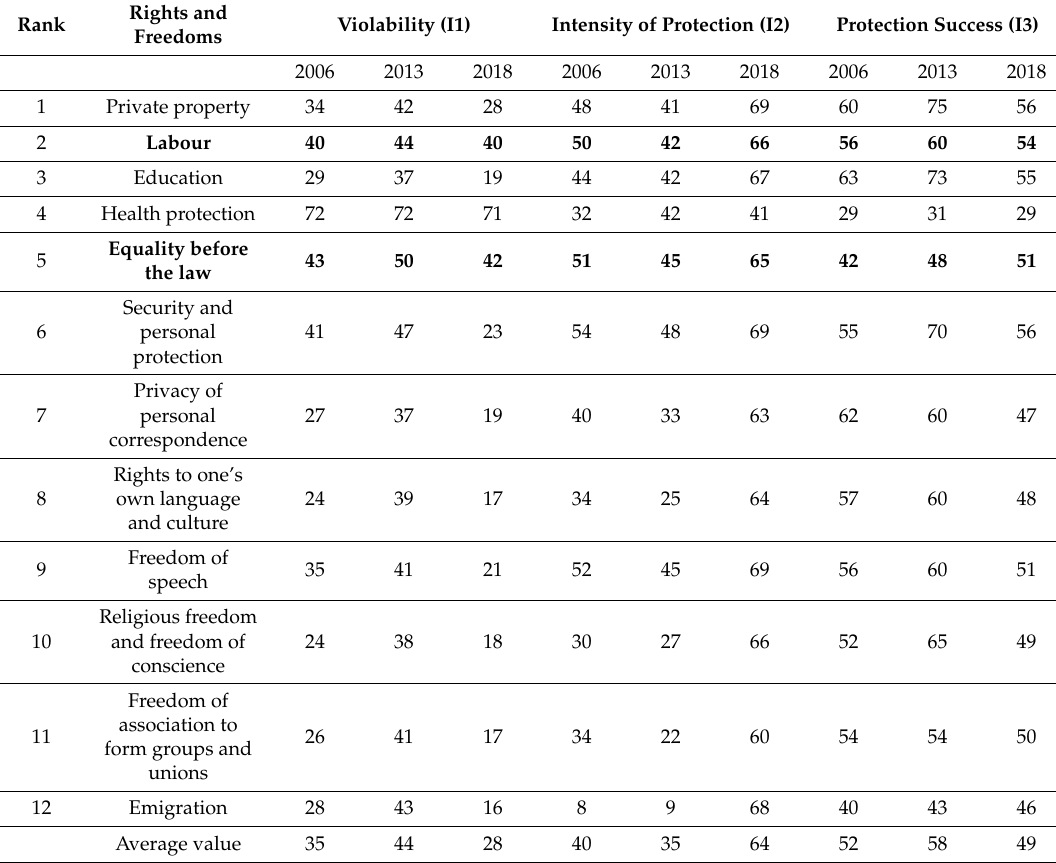
Table A1. Dynamics of the assessments of violation, intensity and success in the protection of the fundamental rights and freedoms of a citizen (% of the number of respondents).